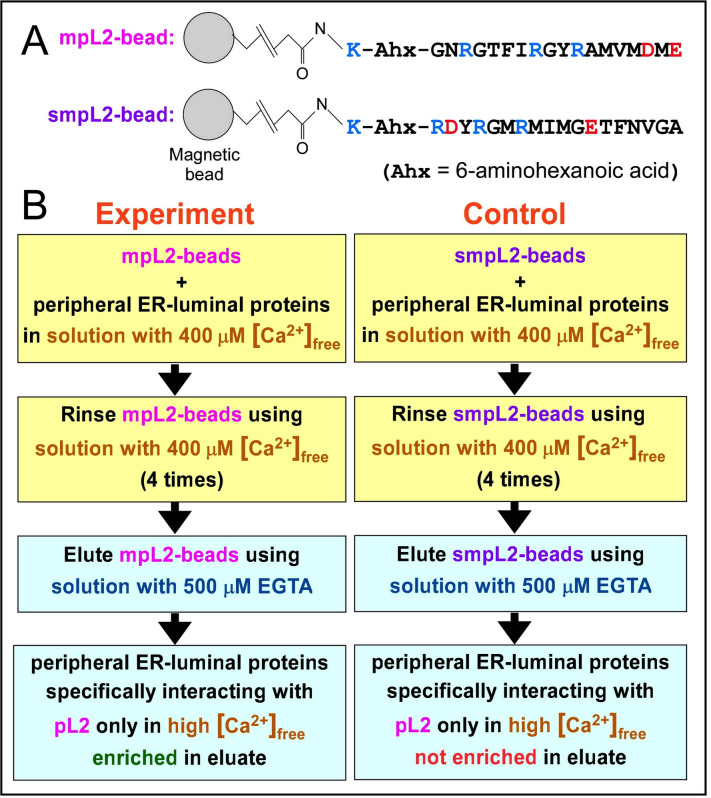
Pull-down of peripheral luminal proteins that interact with IP3R-3 L2 loop.(A) Peptides with modified pL2 (mpL2) or scrambled modified pL2 (smpL2) sequences were immobilized on magnetic beads. (B) Protocol to enrich soluble proteins from bovine ER-microsome fractions that interact with pL2 peptide in presence of high physiological [Ca2+].